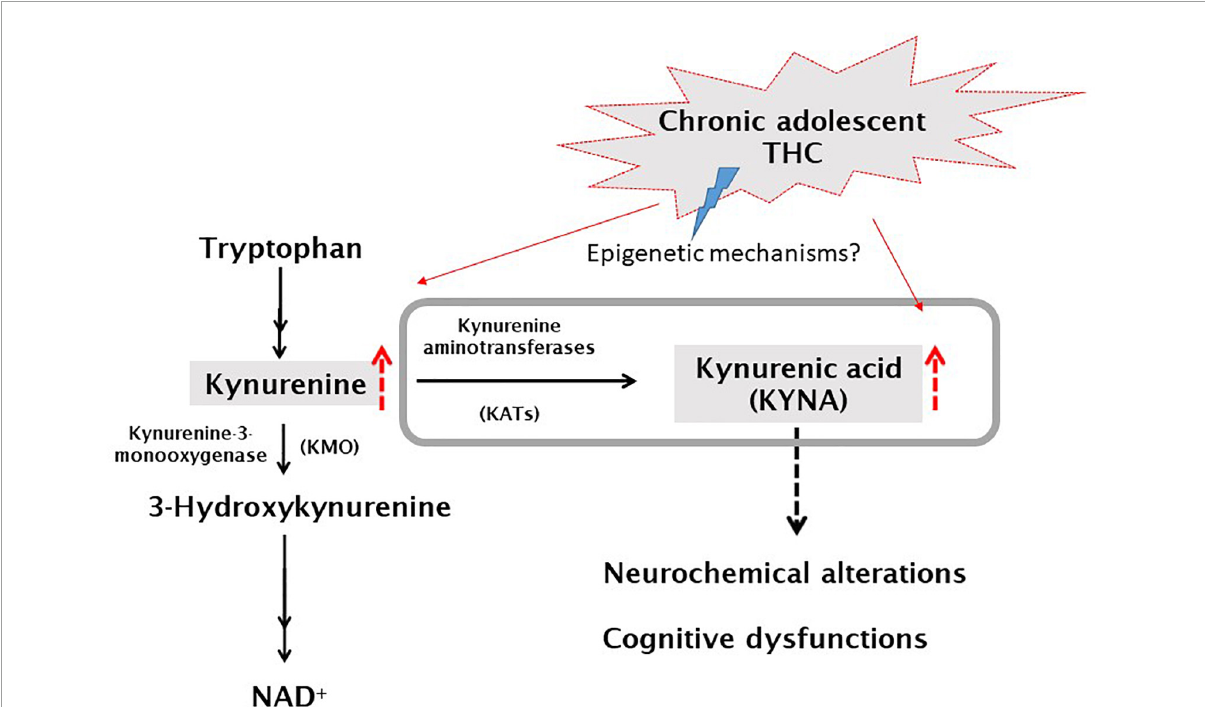
FIGURE8 Simplified graphic representation of the kynurenine pathway and the current working hypothesis. Grey box represents what has been analyzed in this study. Hypothesized mechanism: ascending doses of delta 9-tetrahydrocannabinol (THC) administered twice a day (for details see section “Materials and methods”), to adolescent rats (PD35-45), would induce, possibly by epigenetic mechanisms, an increase of KYNA levels which, in turn, leads to neurochemical and cognitive dysfunctions [(22), for